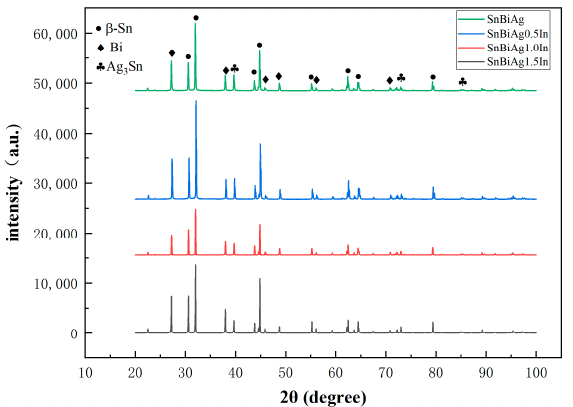
Figure 5. XRD patterns of SnBiAg–xIn (x = 0, 0.5, 1.0, 1.5) solder alloy.